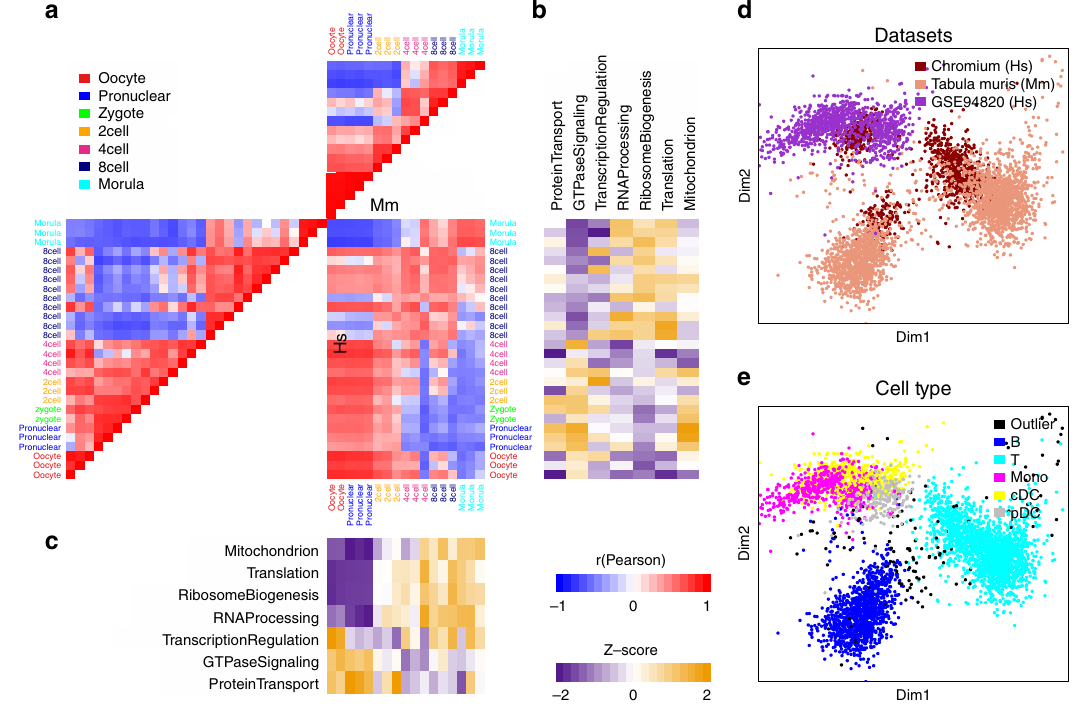
Fig. 2 BPA-based human – mouse integrative analysis. a Human and mouse early embryo single cells were taken from ref. 2 . Pairwise correlation of cells shown as a heatmap; high, red; low, blue. b Inferred activity of biological processes described in the original study for the mouse data set; high activities, yellow; low activities, purple. c Same as in b but for the human data set. d Multidimensional scaling (MDS) view of the cross-species BPA-integrated immune cell studies from human and mouse including two human studies — Chromium, brown; and GSE94820, purple — and one mouse study — Tabula Muris, peach. e Same data as in d showing the MDS view of the distinct immune cell types (colors) showing how cell types (e.g. T-cells, light blue) from both species cluster near one